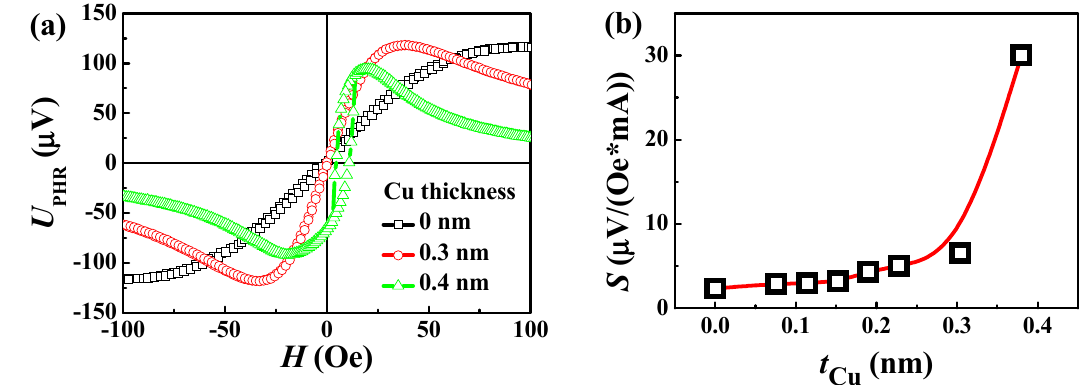
Figure 2. ( a ) PHR curves for the sensors based on varying Cu spacer thickness and ( b ) sensitivity on effective thickness of the Cu spacer layer.